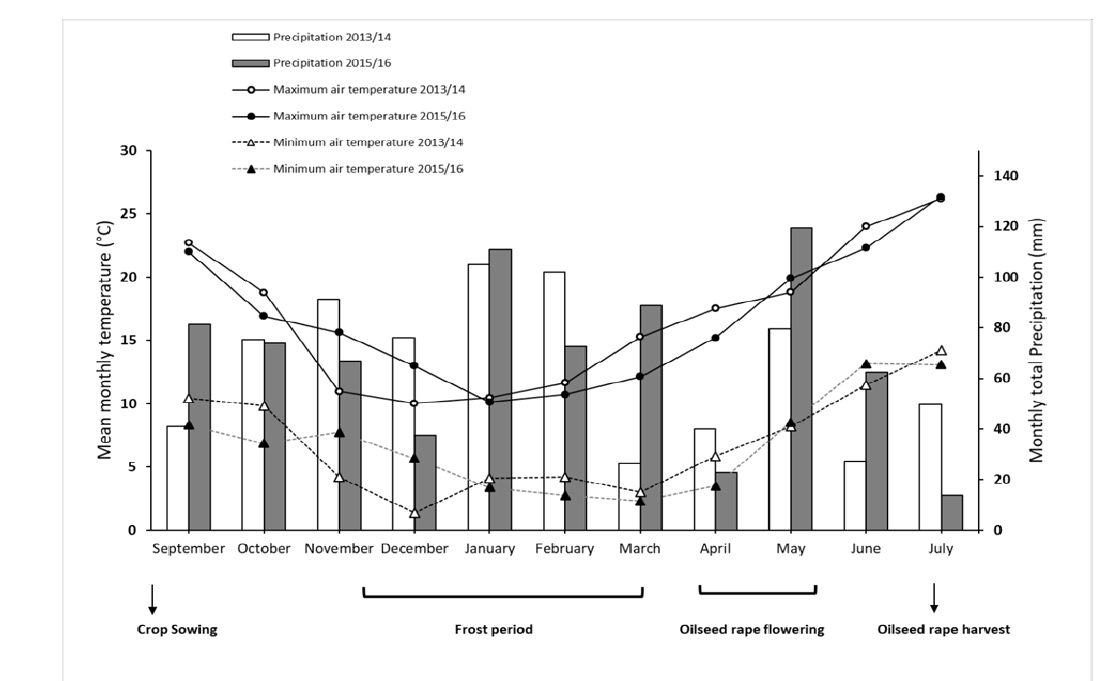
Figure 1. Mean monthly temperature and monthly total precipitation during the 2013/14 and 2015/16 experimental years.